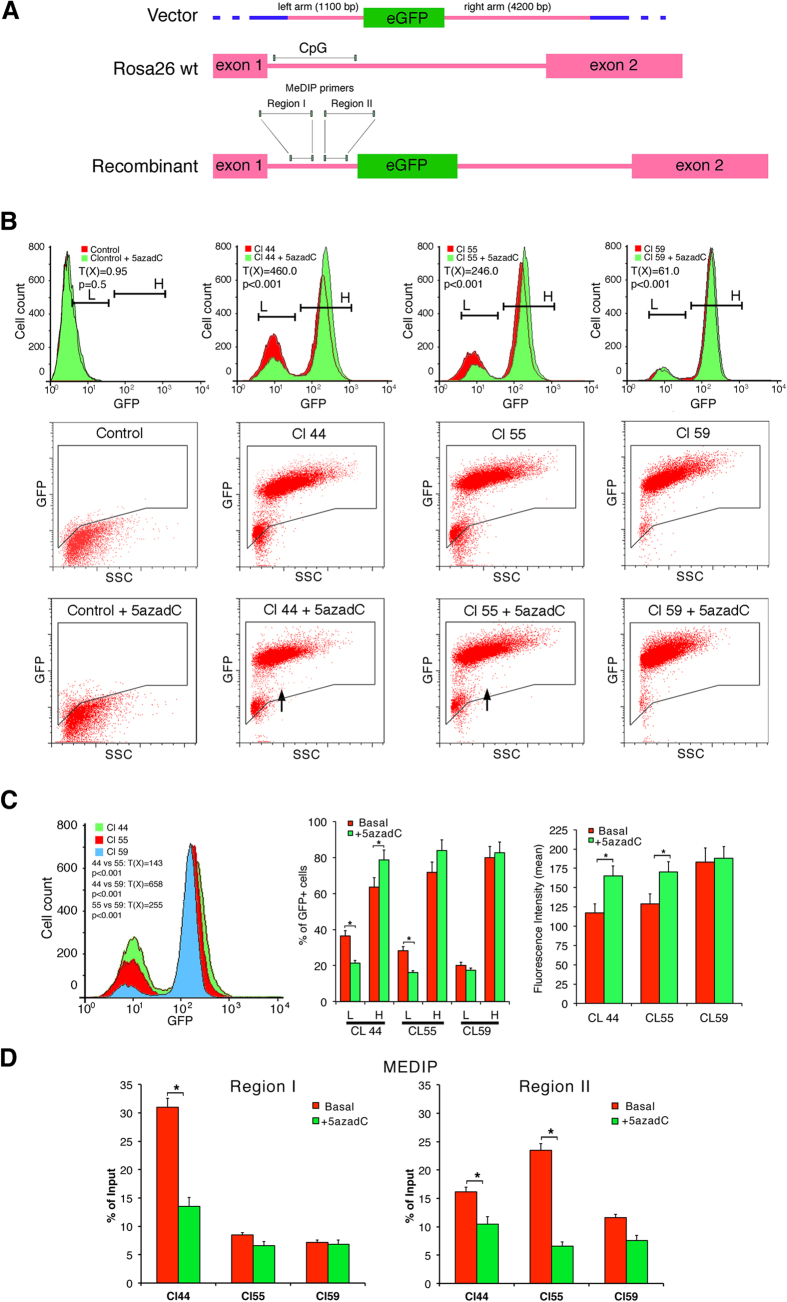
Homologous targeting of GFP to the mouse Rosa26 locus generates ES clones with variable DNA methylation and GFP expression.Three independent ES clones in which the EGFP gene was targeted to the mouse Rosa26 locus, (kindly provided by A. Simeone and D. Acampora, Intern. Inst. Gen. Biophys., IGB, Naples, Italy). These clones, containing a single copy integrated GFP, were purified 7 days after transfection with the targeting vector, amplified and analyzed by cytofluorimetry as described in Methods. The same clones were exposed to 5-azadC (0.5 μM) for 4 days and analyzed 48 h later. Panel (A) shows: 1. the structure of the targeting vector; the two homologous regions are shown in red; 2. the structure of the mouse Rosa26 locus and; 3. the structure of the targeted locus. A segment at the 5′ end, containing a CpG island, is shown (lines). The primers for MEDIP analysis are located in regions I and II. Panel (B) shows the cytofluorimetric analysis of the 3 clones exposed or not to 0.5 μM 5-azadC for 4 days and analyzed 48 h later. Dot Plot scans are shown to illustrate the composition of GFP+ or GFP− cells. The arrows indicate the shift of the L population after 5-azadC treatment. Differences in GFP expression between control and 5-azadC treated cells were tested for statistical significance using the Chi Square test, T(X), (Population Comparison module of the FlowJo software from Tree Star). Cl 44, untreated vs 5-azadC T(X) = 460, p > 0.001; Cl 55, untreated vs 5-azadC T(X) = 246, p > 0.001; Cl 59, untreated vs 5-azadC T(X) = 61, p < 0.001. (C) The panel on the left shows the overlapping profiles of the three clones without treatment to compare the relative GFP expression levels. Cl 44 vs Cl55 T(X) = 143, p < 0.001; Cl 44 vs Cl59 T(X) = 658, p > 0.001; Cl 55 vs Cl59 T(X) = 255, p > 0.001. The central and the left panels show the quantitative analysis of GFP expression in Rec H and Rec L cells before or after 5-azadC treatment as % of GFP+ cells and mean of fluorescence intensity. In the left panel, Rec H and Rec L clones were analyzed together. Differences between treatments were tested for statistical significance using matched pairs t test: *p < 0.001. Panel (D) shows MEDIP analysis of region I and II, respectively in the 3 clones. *p < 0.001.